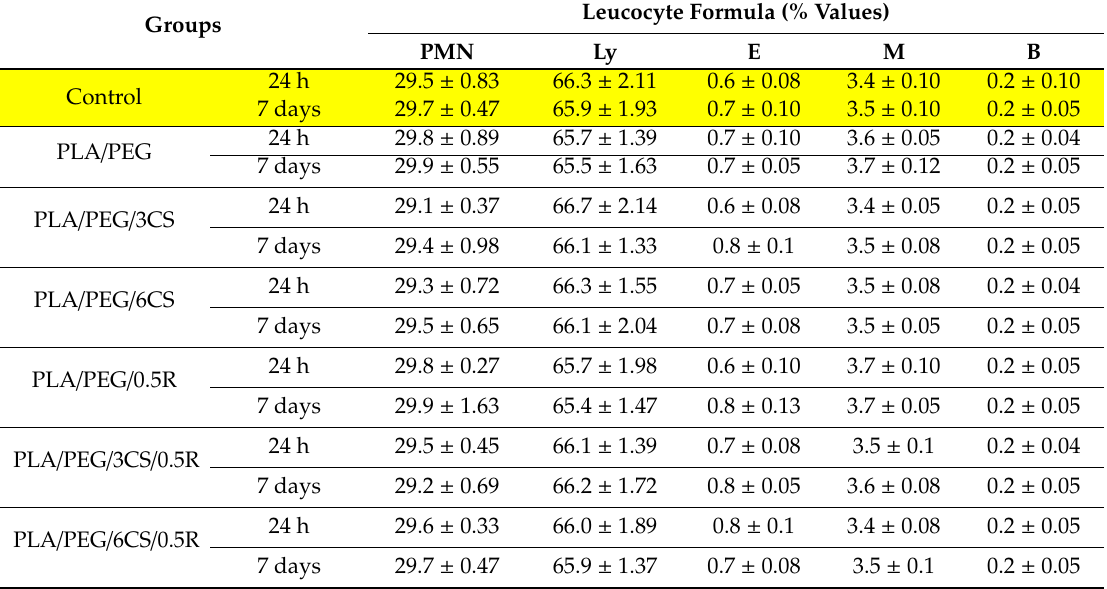
Table 9. The influence of biocomposite implants administration on the elements of the leucocyte formula. Values were presented as mean ± S.D. for six animals in a group.